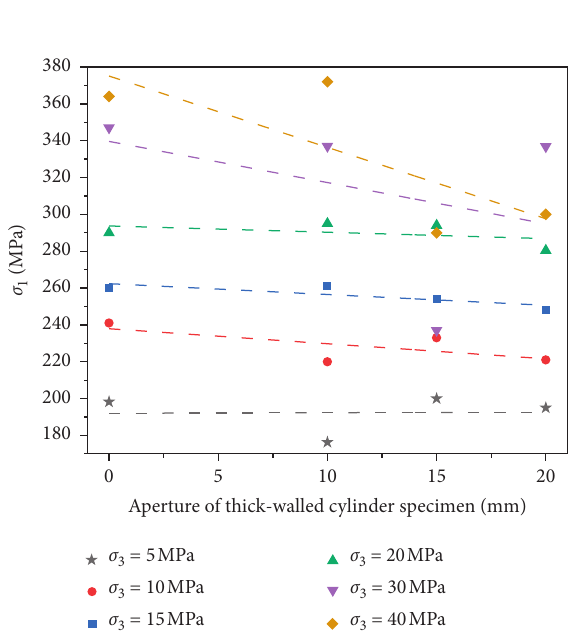
Figure 9: Fitting curves between the aperture and peak TCS.